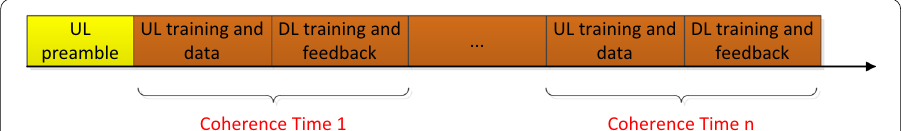
Fig. 3 The transmission data phase diagram. Shows the system data transmission, which is divided into two stages: uplink preamble and data transmission. The data transmission stage includes the uplink and